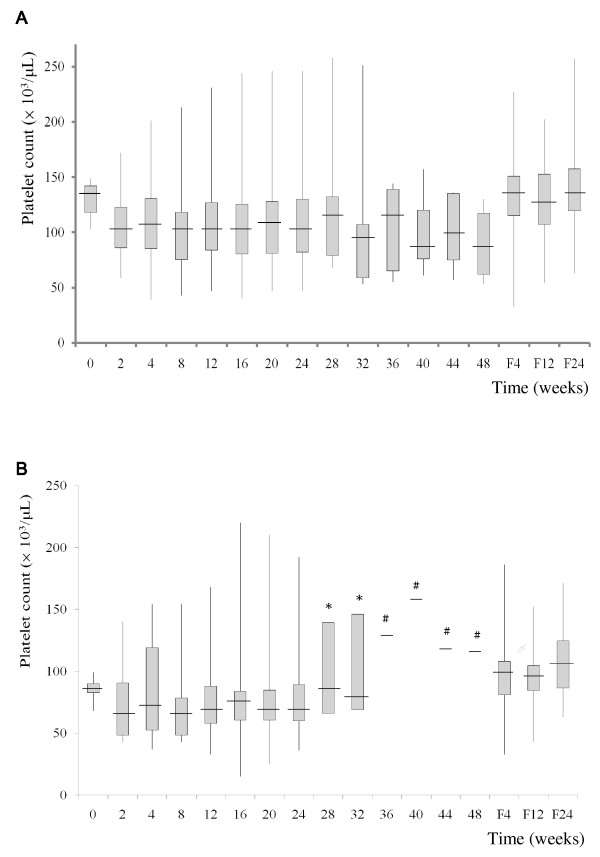
Sequential changes in platelet counts during treatment with peginterferon-α and ribavirin in patients with pretreatment platelet counts between 100,000/μL and 150,000/μL (1A), and < 100,000/μL (1B). Each vertical line represents the range of platelet counts. Each shaded area represents the 25th - 75th percentiles, and each short horizontal line represents the median. F4, F12, and F24 mean follow-up weeks 4, weeks 12, and weeks 24, respectively. *: Number of the patients was 3. #: Number of the patients was 1.